Question: Provide a one-line summary of what is displayed.
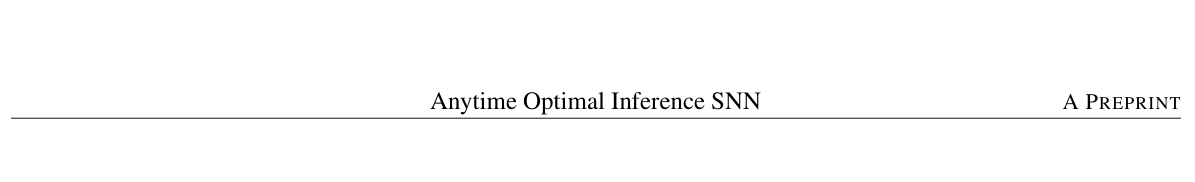
Answer: Comparison of accuracy with respect to timestep on six datasets. Each STR-based model employs the same α setting from Table 1. The results present the accuracy performance using fixed timesteps and cutoff.